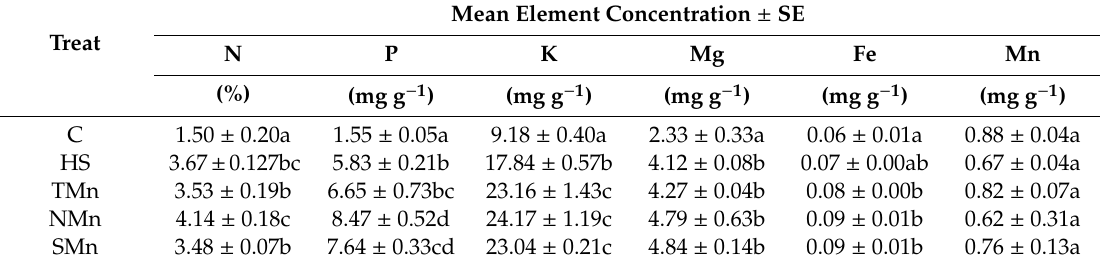
Table 6. E ff ect of manganese fertilization treatments 1 (Treat) on the mean 2 elemental content of 12-week-old red maple ( Acer rubrum L.)